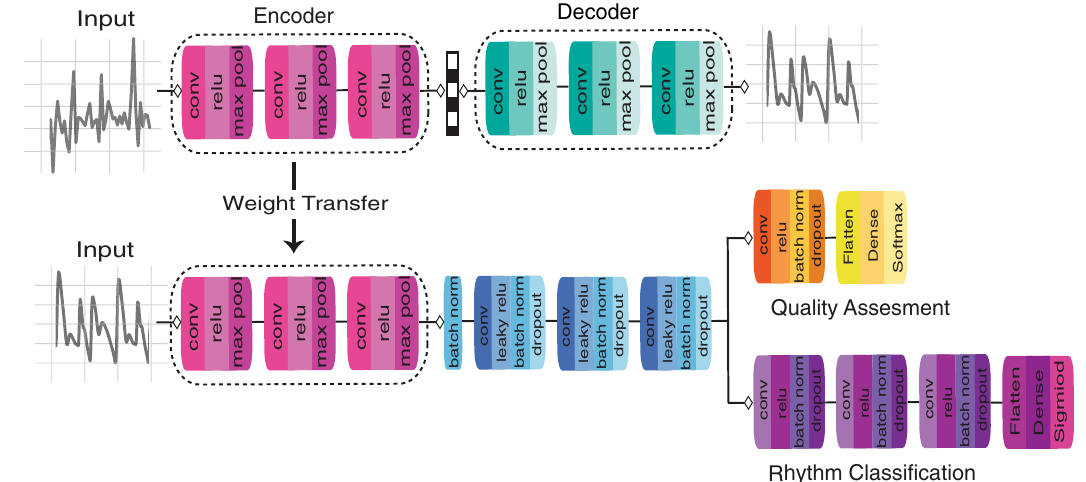
Fig. 1 DeepBeat model architecture. The proposed model architecture for DeepBeat, two tasks are shown: (top) unsupervised pretraining and (bottom) supervised learning through fi ne-tuning. The top represents the pretraining process on the unlabeled simulated data, and the bottom represents the multitask fi ne-tuning process on the labeled data. The trained encoder weights serve as the foundational layers of the multitask model.